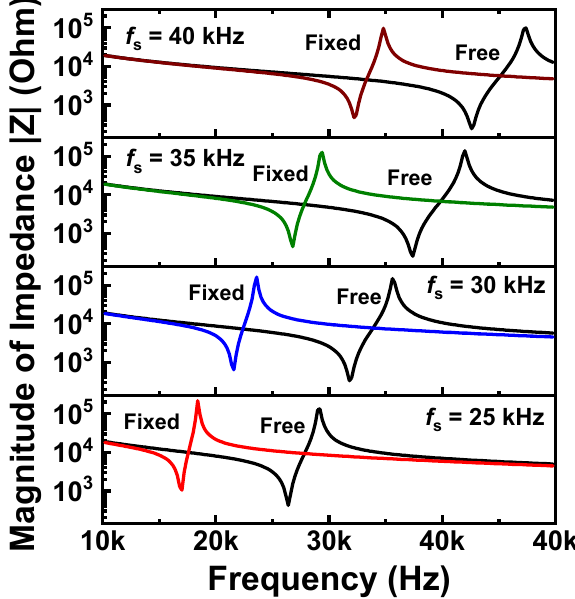
Figure 5. Impedance ‐ frequency spectra obtained from numerical simulation using free and fixed Figure 5. Impedance-frequency spectra obtained from numerical simulation using free and fixed boundary conditions for optimized designs ( f s = 25, 30, 35, 40 kHz).